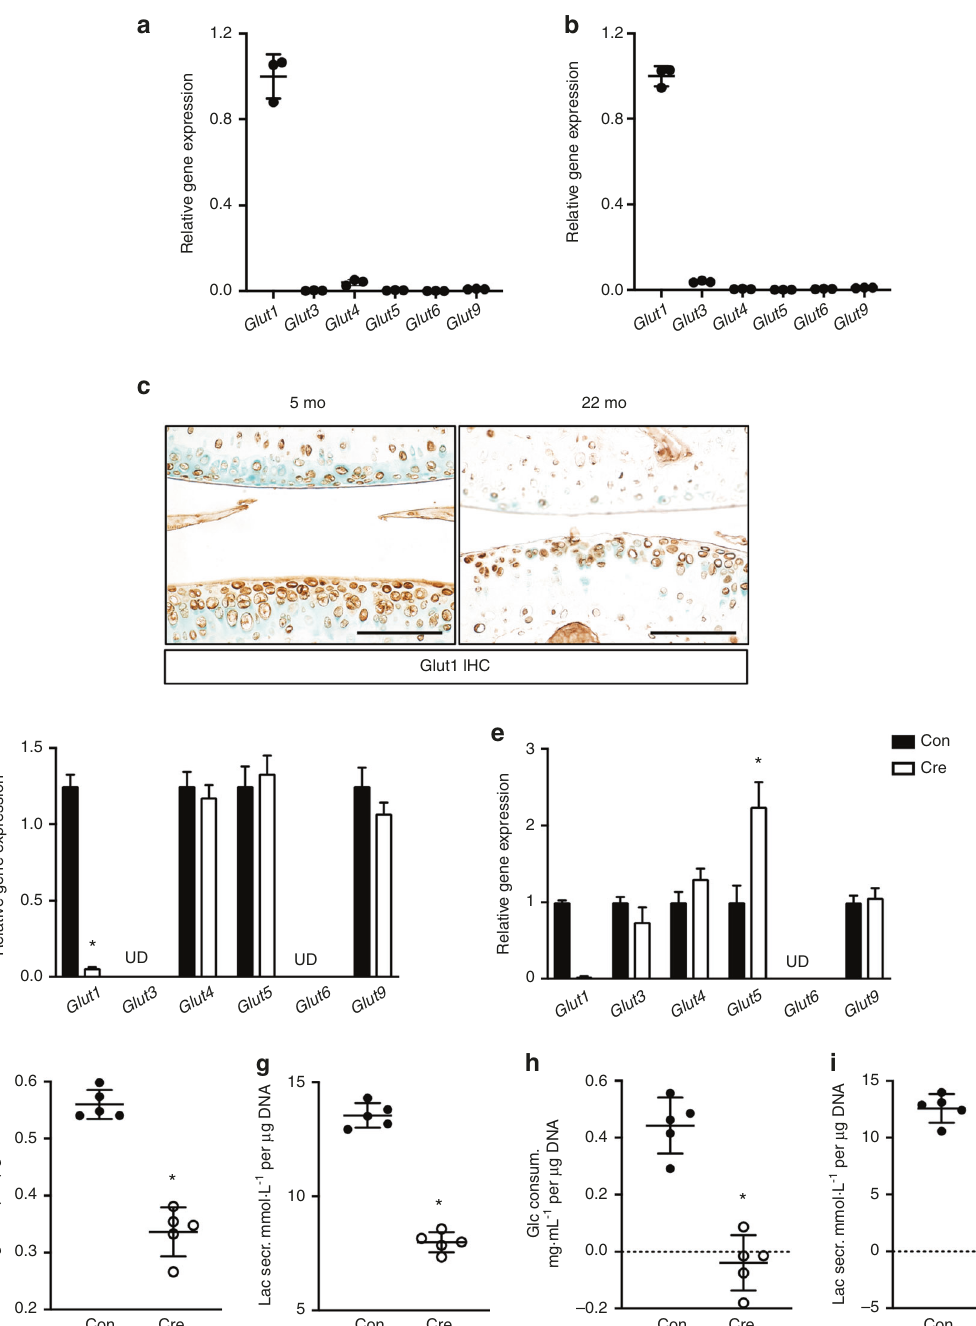
Fig. 1 Glut1 encodes the primary glucose transporter in primary chondrocytes, and deletion of Glut1 leads to diminished glucose metabolism in chondrocytes. N = 3. a – b Gene expression of different glucose transporters in normal primary costal (GP) chondrocytes ( a ) and articular (AC) chondrocytes ( b ) as assayed by RT-qPCR. All mRNA abundances were normalized to that of β -actin . N = 3. * P < 0.05. c Immunostaining for Glut1 in knee sections of C57/BJ6 wild-type mice at 5 and 22 months. N = 3. Scale bar, 100 μ m. d – e Gene expression of different glucose transporters in Ad-Con (control; Con)- or Ad-Cre (KO)-transduced Glut1 f/f primary GPs ( d ) and AC chondrocytes ( e ). The abundance of each individual mRNA in Glut1 KO cells was normalized to that in control cells. N = 3. * P < 0.05. f – i Glucose consumption and lactate secretion by control and Glut1 KO primary GP ( f – g ) and AC ( h – i ) chondrocytes over 24 h. The data were normalized to the genomic DNA content and are expressed as the mean ± SD. N = 5. * P < Glut1 is indispensable for the maintenance of AC homeostasis of Glut1 LOF GPs and showed no obvious difference relative to AC also displayed abnormalities upon loss of Glut1 postnatally. the control animals (Supplementary Fig. 2b). These fi ndings together suggest that Glut1 and glucose metabolism are critical for GP elongation and cartilage matrix synthesis and turnover/ remodeling.